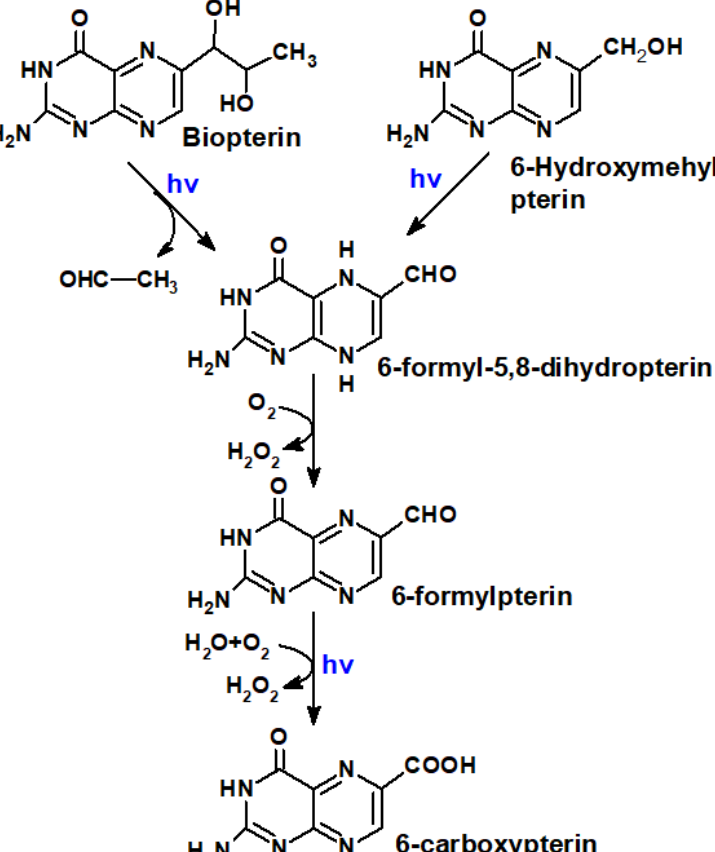
Figure 11. 6-Biopterin and 6-hydroxymethylpterin photo-oxidation scheme [177].